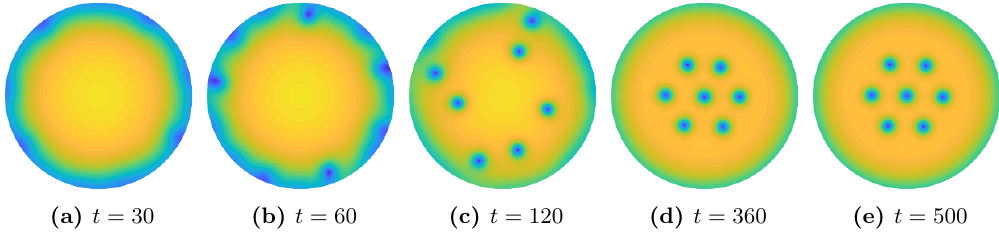
Figure 4. Condensates as functions of space coordinates at di(cid:11)erent time when (cid:10) = 0 : 168. In this plot, 7 vortices appear, which form the simplest triangular